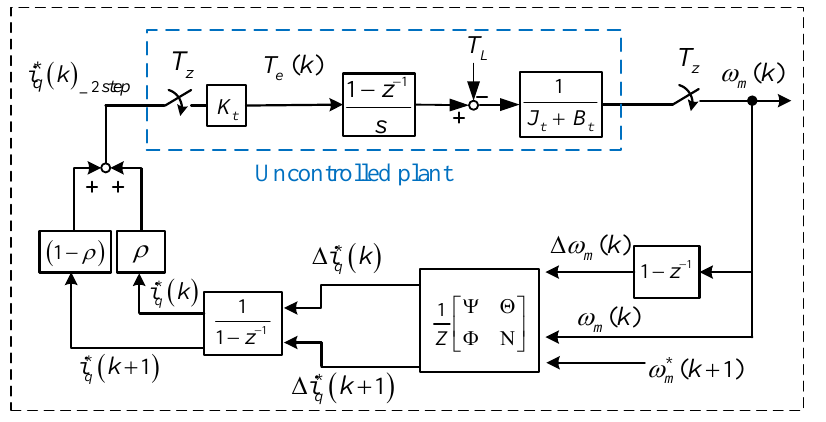
Figure 7. Block diagram of two-step predictive speed control.